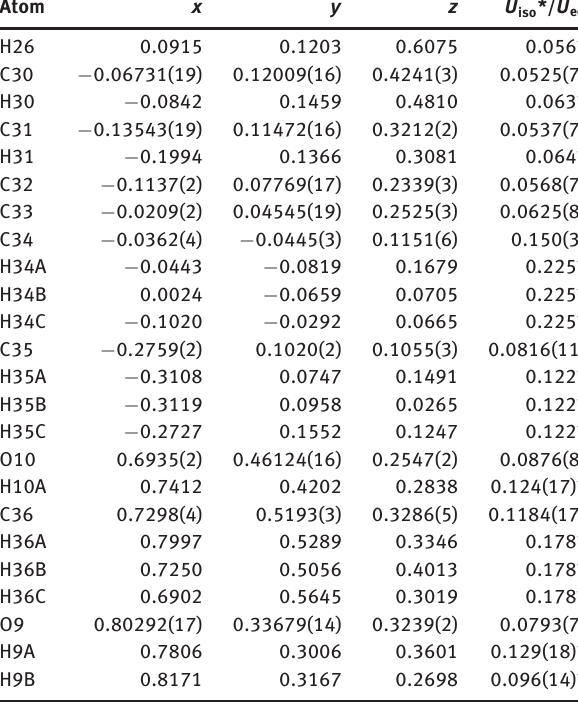
Table 2: Fractional atomic coordinates and isotropic or equivalent isotropic displacement parameters (Å 2